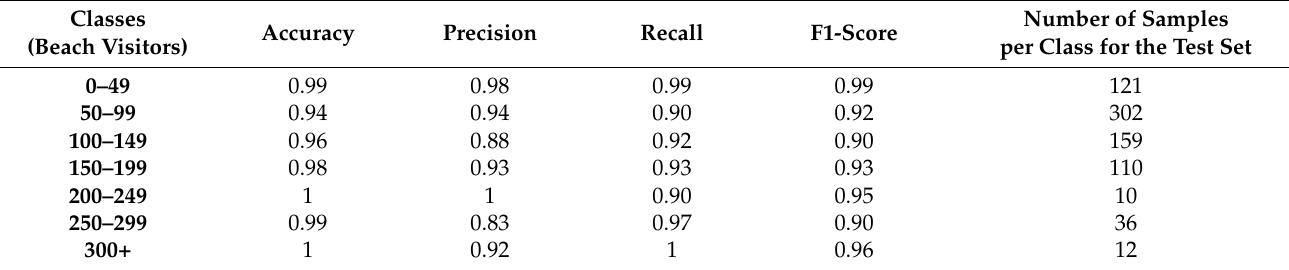
Table 5. MAE, accuracy, precision, recall, and F1-score.